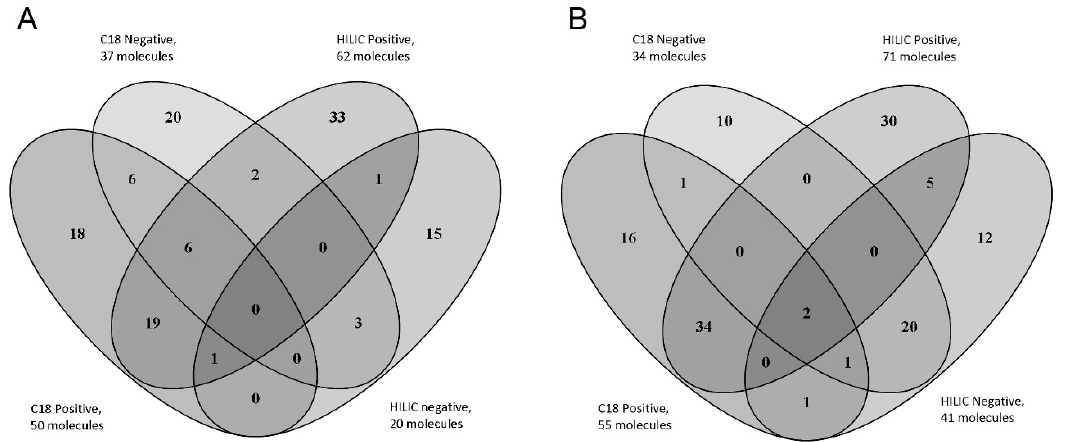
Figure 2. Metabolomic analysis of plasma ( A ) and urine ( B ) pool samples. Venn Diagram of the total number of level 1 identified metabolites in real samples using reversed phase and HILIC columns both in positive and negative polarities.